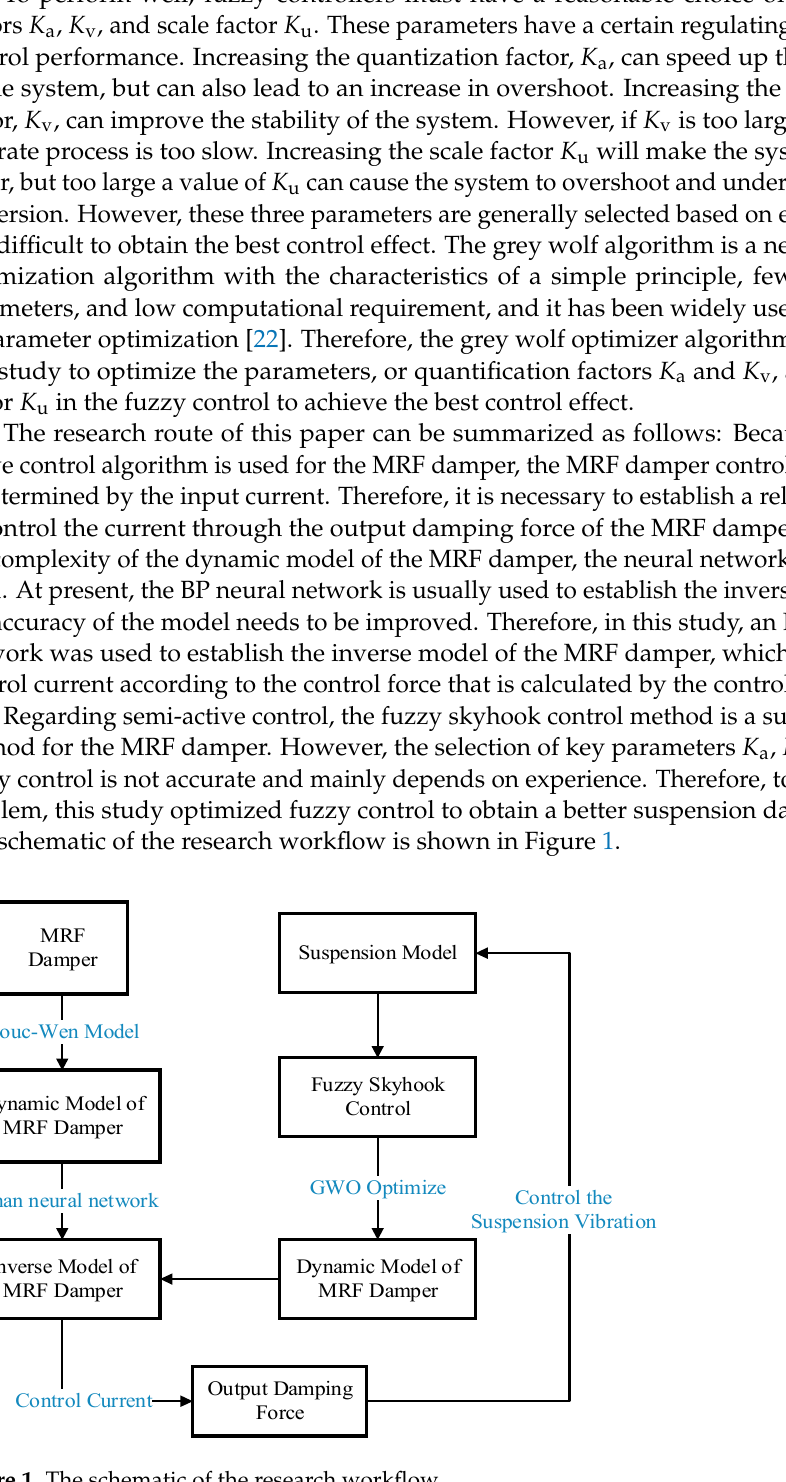
Figure 1. The schematic of the research